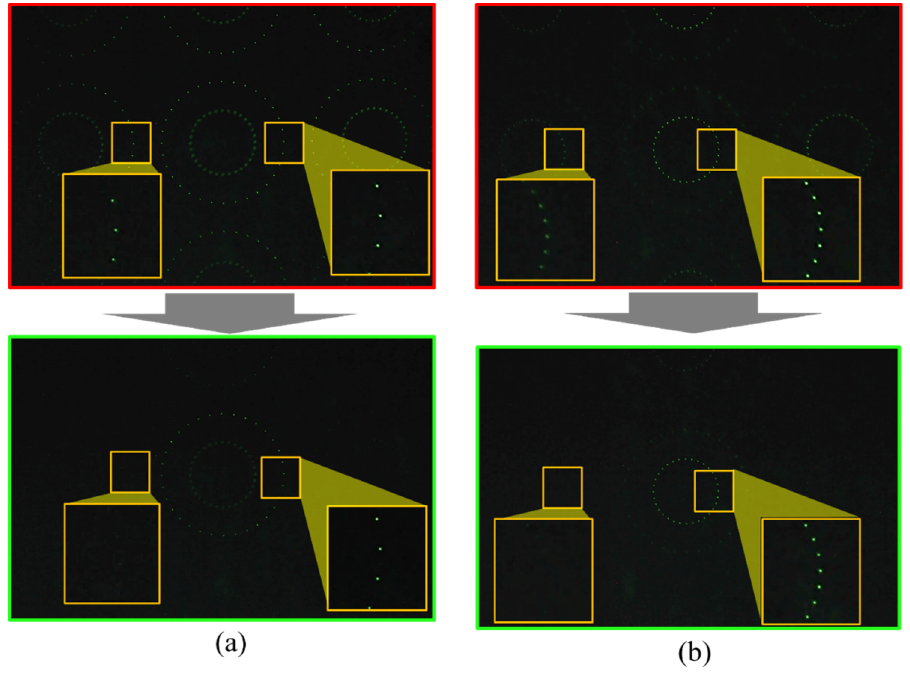
Figure 8. ( a ) Reconstructed holographic image without using a filter and ( b ) with the proposed non-periodic pinhole array filter.